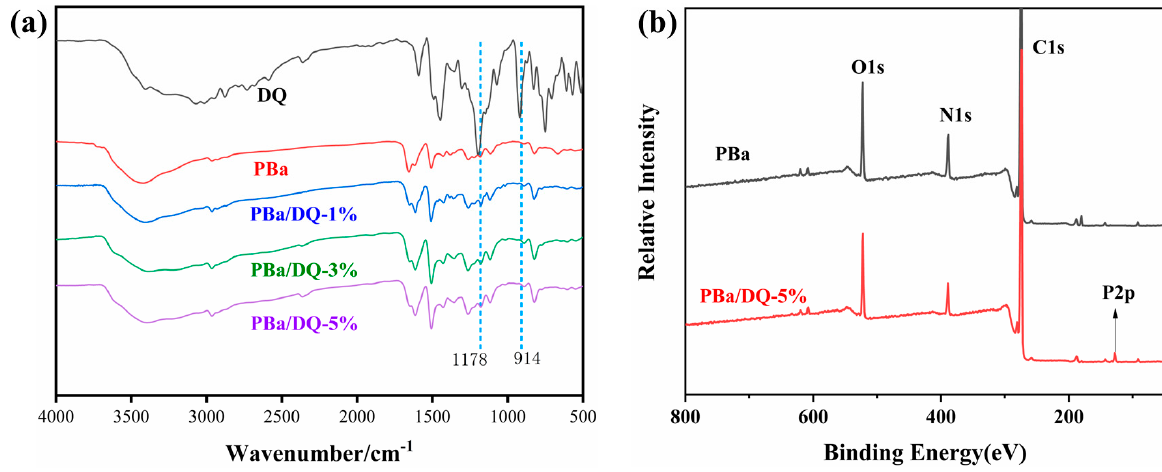
Figure 2. ( a ) The FITR Spectroscopy and ( b ) XPS of Aerogels.